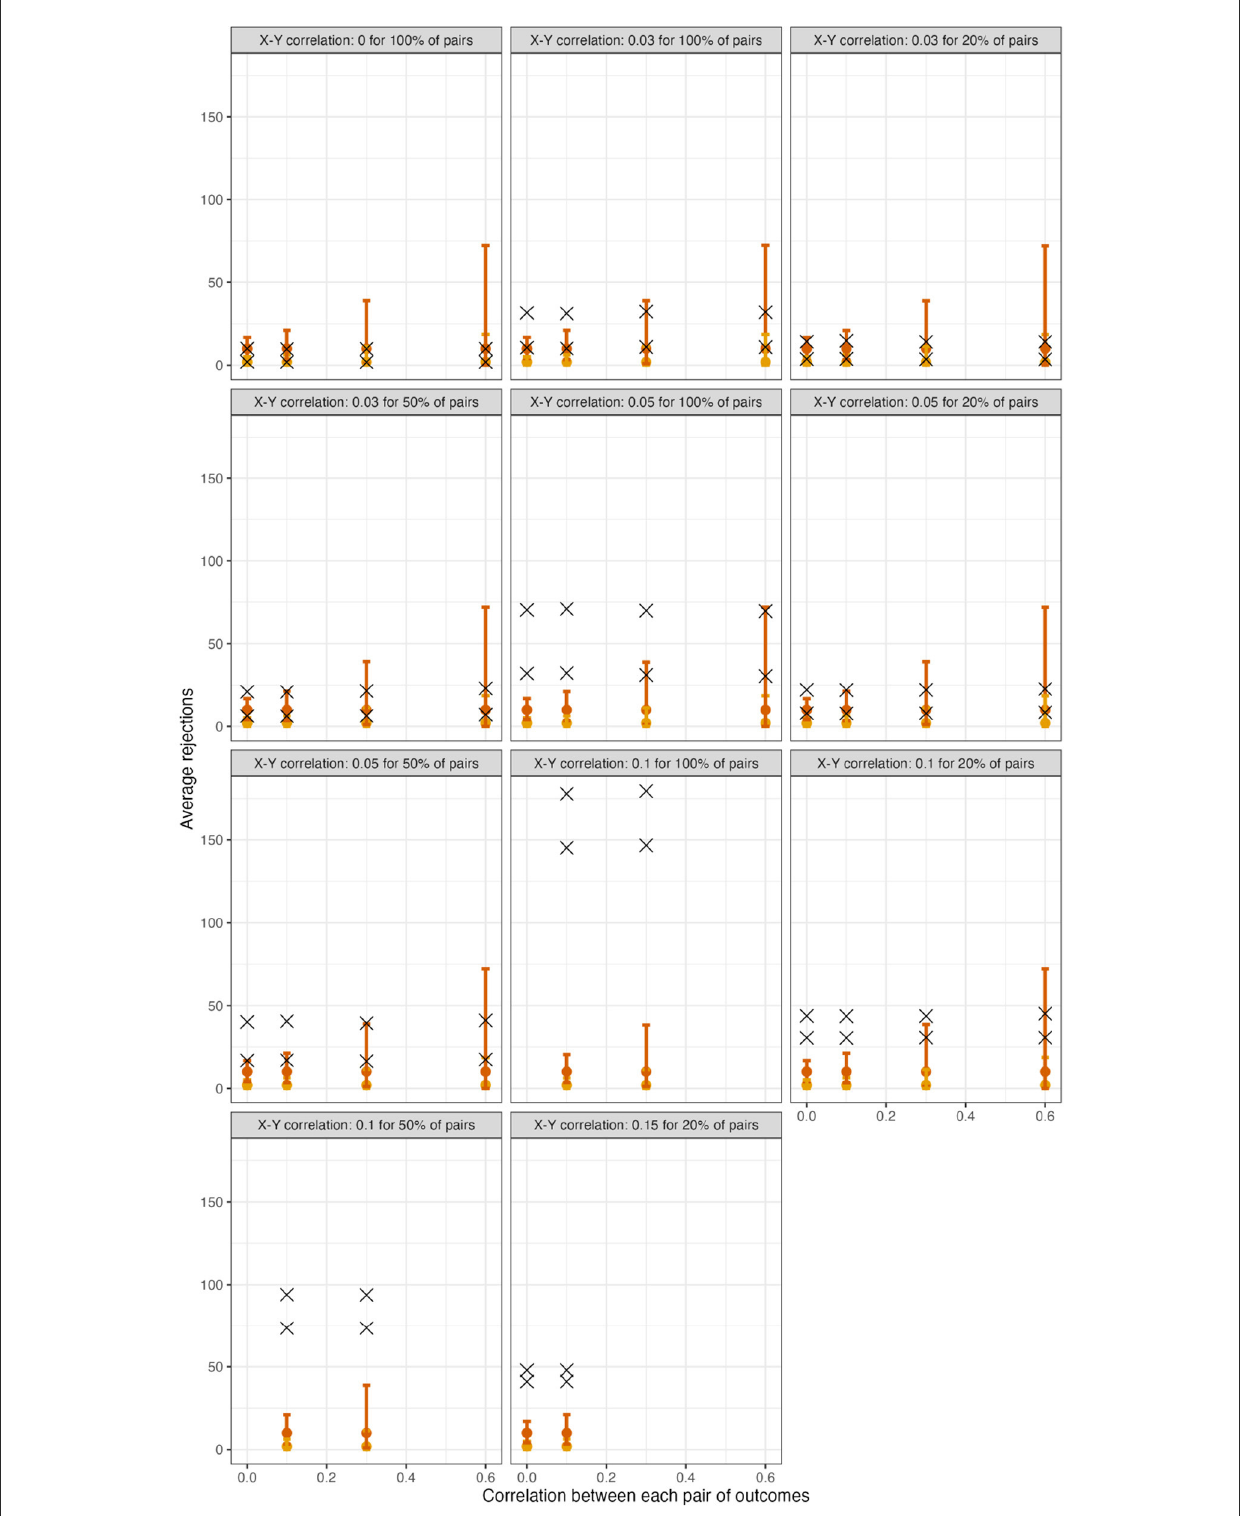
FIGURE2 For scenarios with 200 outcomes, 95% null intervals vs. mean rejections in observed datasets ( × ). Panels: Null and alternative data-generating mechanisms of original samples. Points and error bars: Mean